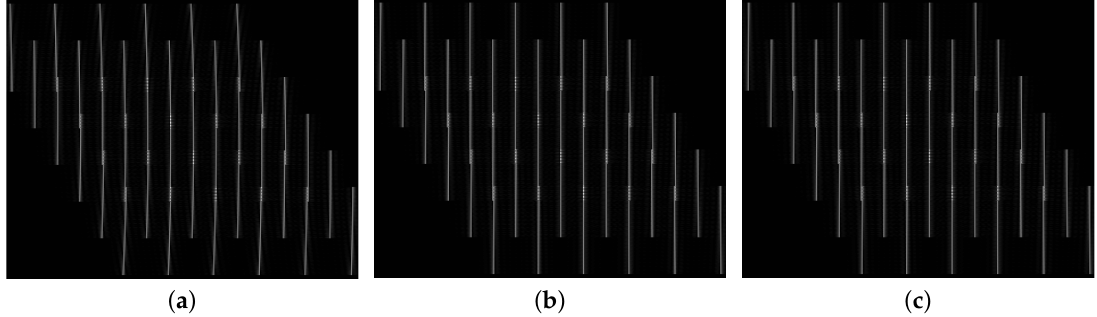
Figure 6. RCM correction results. ( a ) NLCS-based 2-D singular value decomposition (SVD) algorithm with inaccurate movement information. ( b ) NLCS-based 2-D SVD algorithm with accurate movement information. ( c ) The proposed algorithm.